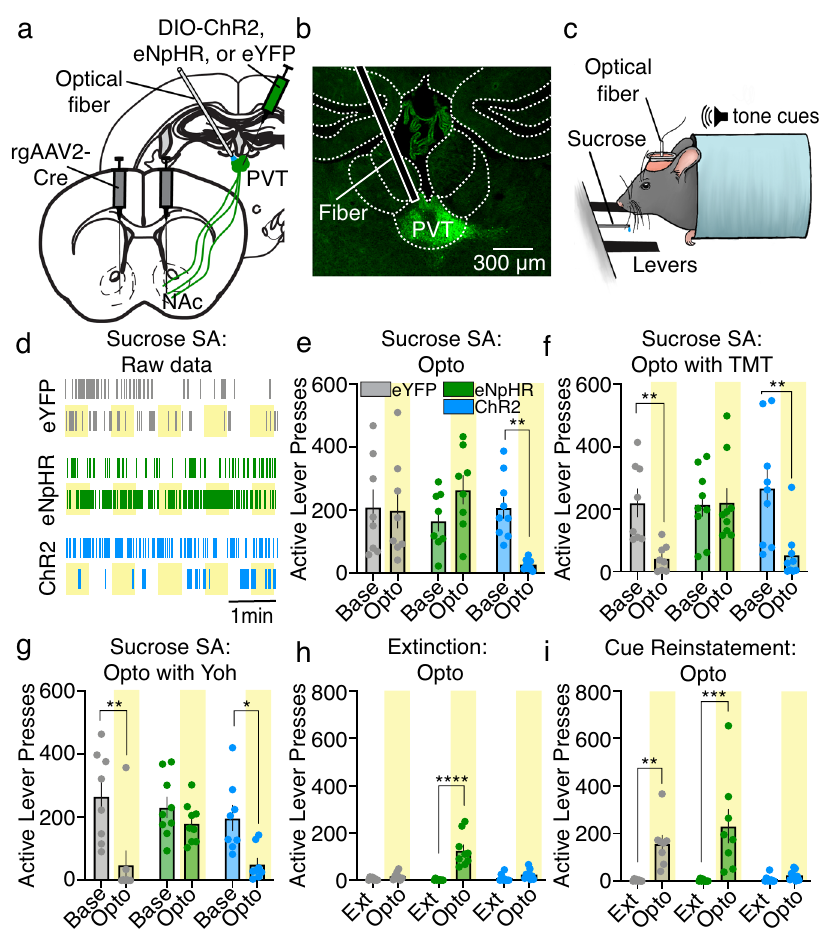
Fig. 2 | PVT → NAc activity dynamics are necessary and suf fi cient for the expression and suppression of sucrose self-administration and seeking. a – c Surgical strategy ( a ) for optogenetic manipulation of PVT → NAc neurons ( b ) during sucroseself-administration( c ;imagemodi fi ed fromVollmeretal. 71 ). d Raster plot showing example active lever pressing rates in each group during sucrose self- administration (examples from 5 mice/group; yellow bar=light on). e Group data showing that optogenetic stimulation of PVT → NAc neurons suppressed active lever pressing ( n =8 eYFP, 8 eNpHR, 9 ChR2 mice; repeated-measures two-way ANOVA, day×groupinteraction: F 2,22 =7.09, P =0.004;Sidak ’ spost-hoc: P =0.006). f – h TMT ( f ), yohimbine ( g ), and extinction ( h ) suppressed active lever pressing, whereas inhibition of PVT → NAc neurons in eNpHR mice rescued active lever pressing (TMT: n =8eYFP,9eNpHR,9ChR2mice;repeated-measurestwo-wayANOVA,day×group